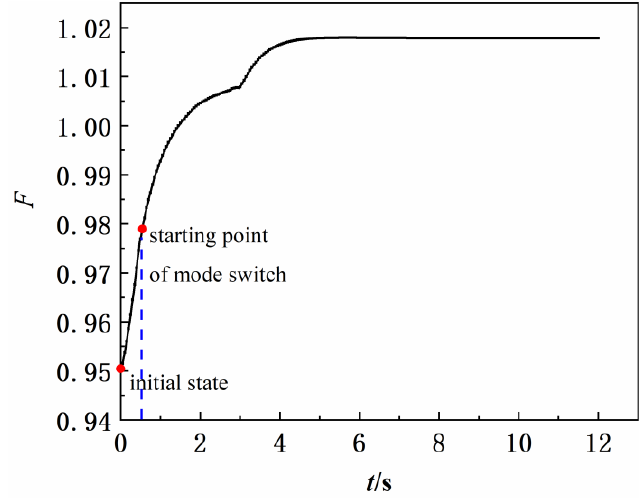
Figure 11. Change curve of thrust of working-mode switching from double bypass to single bypass at H = 0 km, Ma = 0.